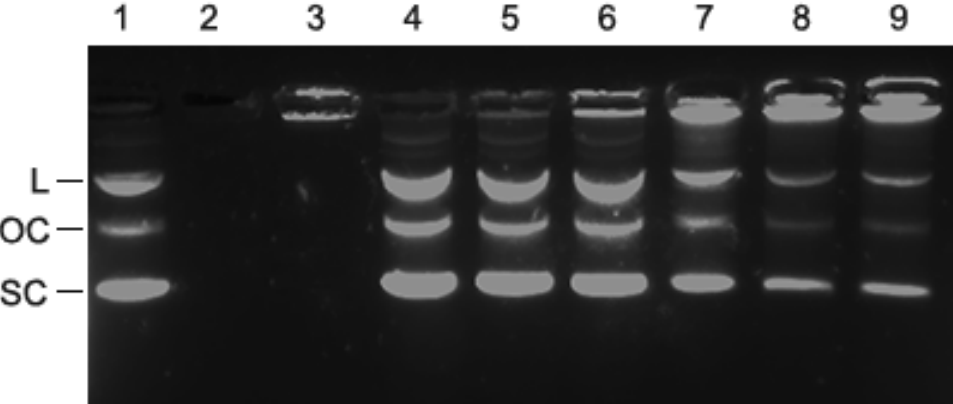
Figure 4. An agarose gel stained with GelRed dye after electrophoresis of plasmid DNA that had been incubated with increasing amounts of PLL-coated birch LNPs (286 nm diameter) shows that the DNA and the PLL-coated LNPs interact. ( 1 ) 50 ng plasmid DNA (positive control). The three DNA bands represent the three configurations of the plasmids as indicated on the left (linear (L), open circle (OC), supercoiled (SC)), that migrate through the gel at different velocities; ( 2 ) 20 ng uncoated birch LNPs, no plasmid DNA; (negative control); ( 3 ) 20 ng PLL + 50 ng plasmid DNA (negative control); ( 4 ) 0.25 ng PLL-coated birch LNPs with 50 ng plasmid DNA (1:200 ratio); ( 5 ) 1.25 ng PLL-coated LNPs with 50 ng plasmid DNA (1:40); ( 6 ) 2.5 ng PLL-coated birch LNPs with 50 ng plasmid DNA (1:20 ratio); ( 7 ) 5.0 ng PLL-coated birch LNPs with 50 ng plasmid DNA (1:10 ratio); (8) 8.3 ng PLL-coated birch LNPs with 50 ng plasmid DNA (1:6 ratio); ( 9 ) 10 ng PLL-coated birch LNPs with 50 ng plasmid DNA (1:5 ratio).